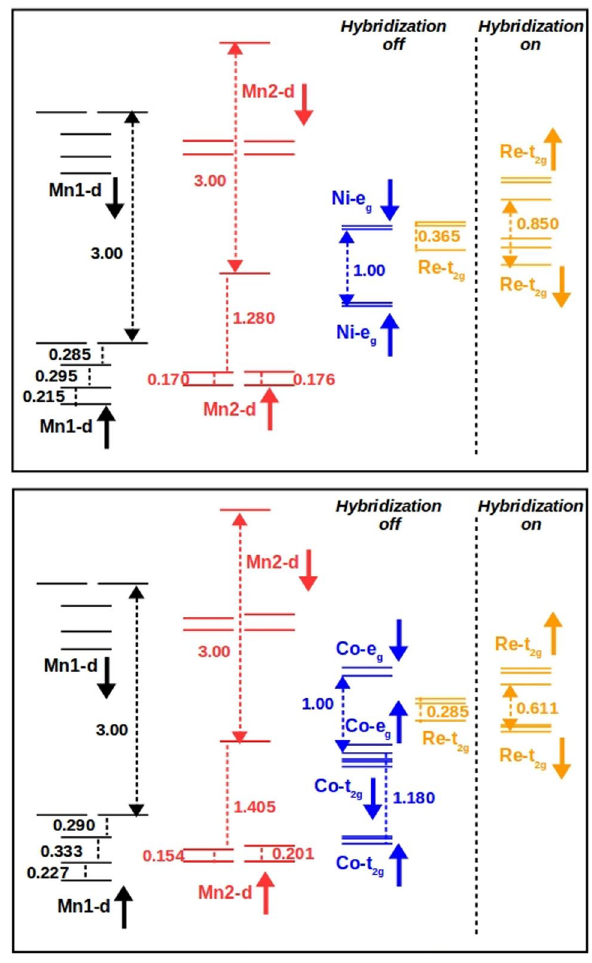
Figure 3. The energy level diagram for CMNRO (top) and CMCRO (bottom) considering Mn1- d /Mn2- d /Ni e g (Co d )/Re t 2 g in basis (Hybridization-off) and in the massively downfolded Re t 2 g only basis (Hybridization-on). See text for details.